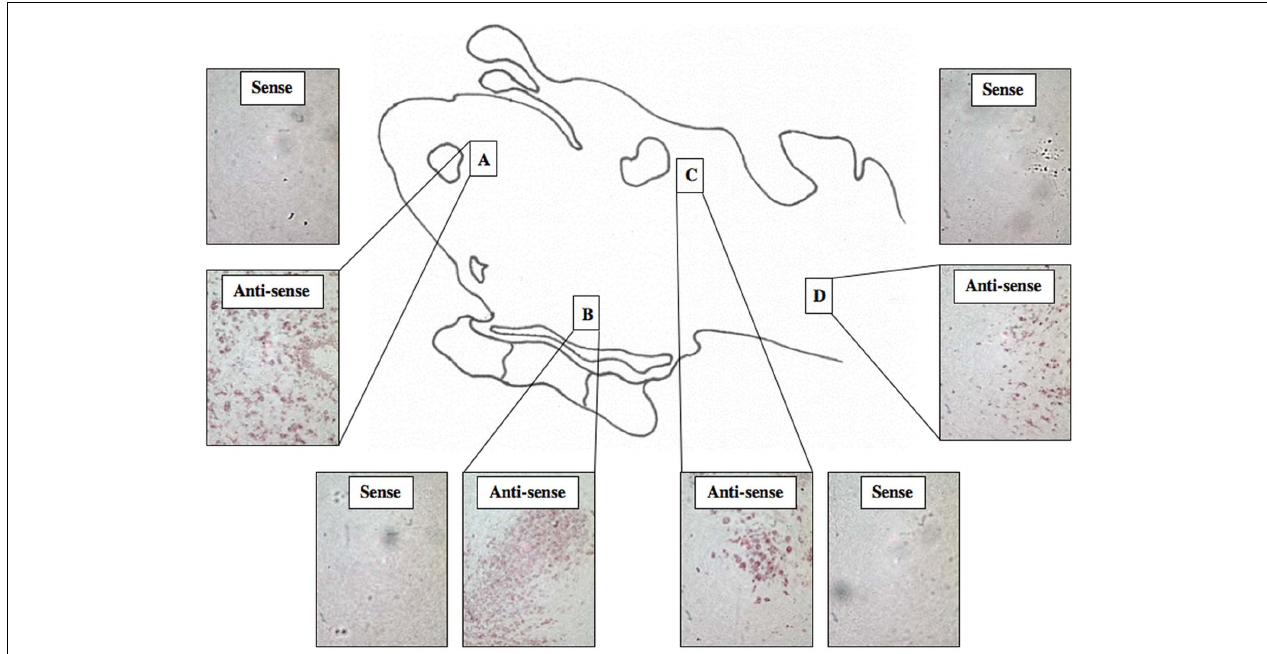
FIGURE 4 | DIG-Labeled In situ hybridization for lamprey ER. Light micrographs of transverse tissue sections showing reaction product using probe ER2 within the olfactory bulb (A) , the hypothalamus (B) , the midbrain (C) , and the hindbrain (D) . (200 × mag).